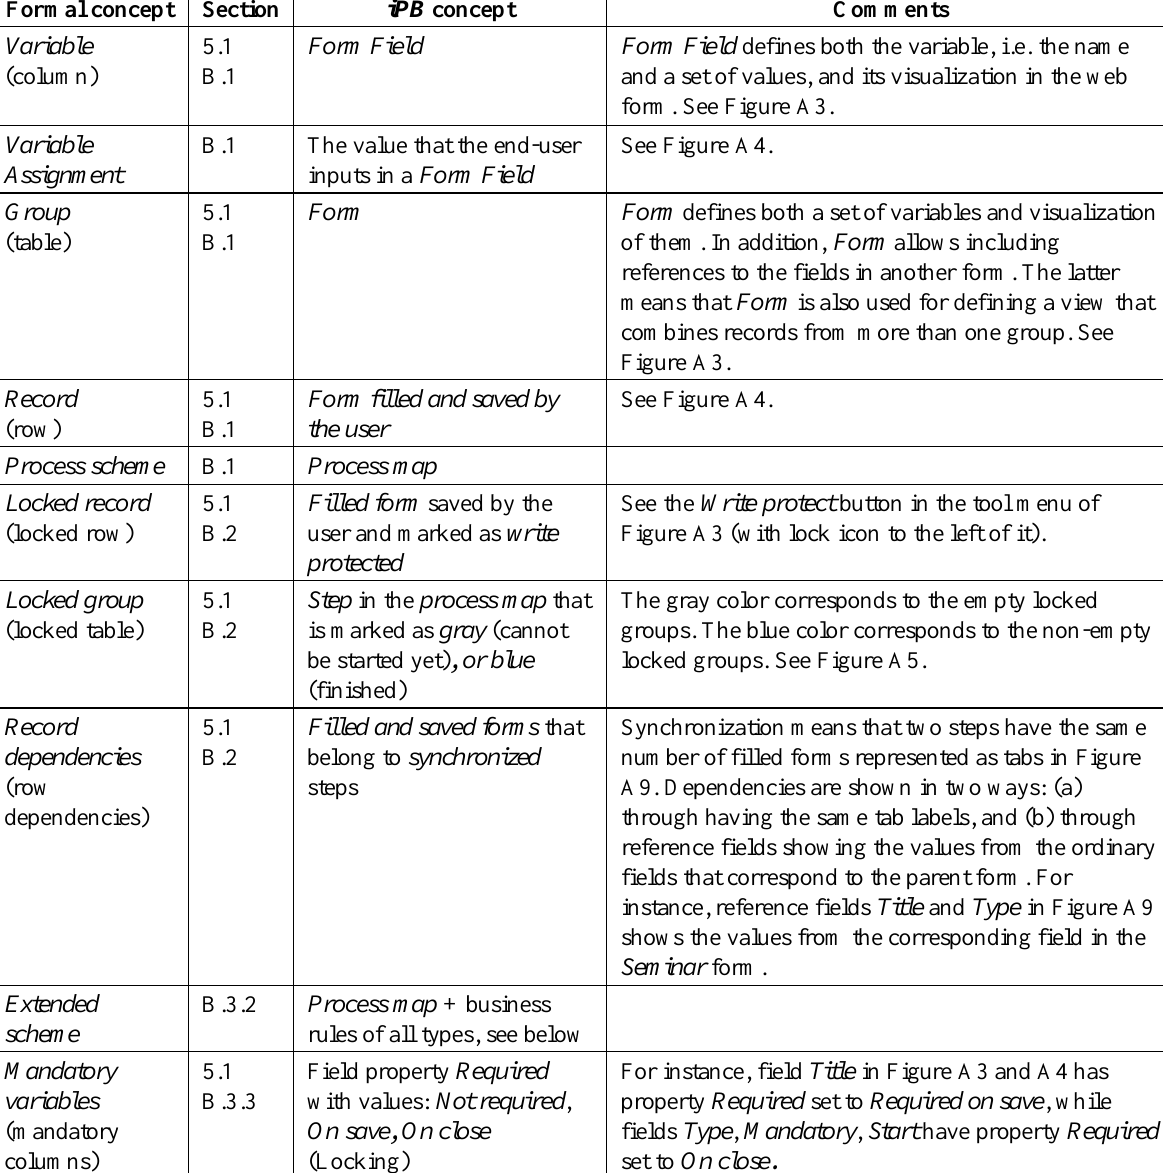
Table 3. Correspondence between Formal and iPB modeling